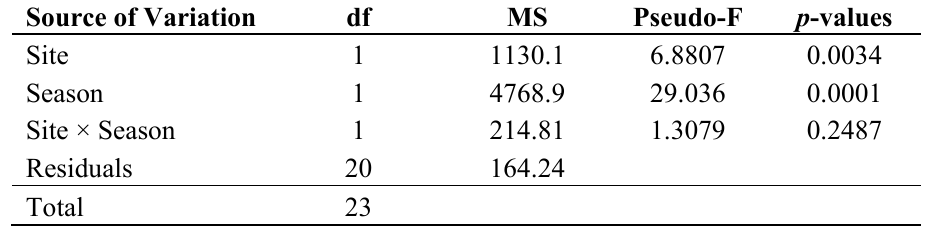
Table 2. Two-way crossed PERMANOVA of pigment composition between sites (S1 and S2) and seasons (winter/spring and summer/autum). Degree of freedom (df), mean square (MS), pseudo-F statistic and permutational p -values are given for each term of the model.